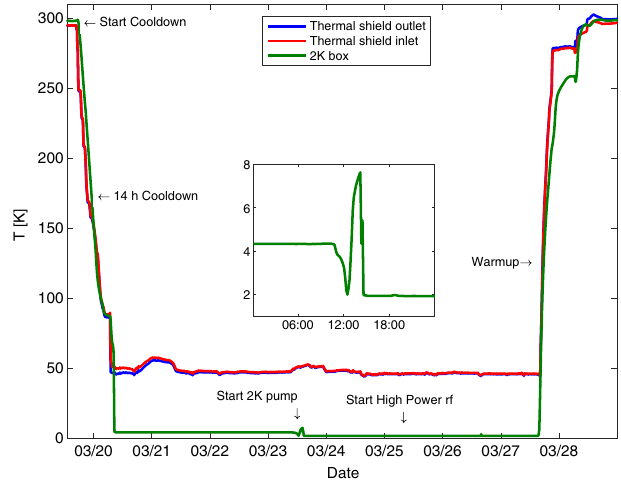
FIG. 5. Cooldown/warmup cycle of the cryoadapter for the 3.9 GHz horizontal tests. The cryogenic circuits are cooled and warmed with a standard procedure requiring approximately 14 h. More than 48 hours were needed for complete thermalization of the cold mass before the 2 K pump down.